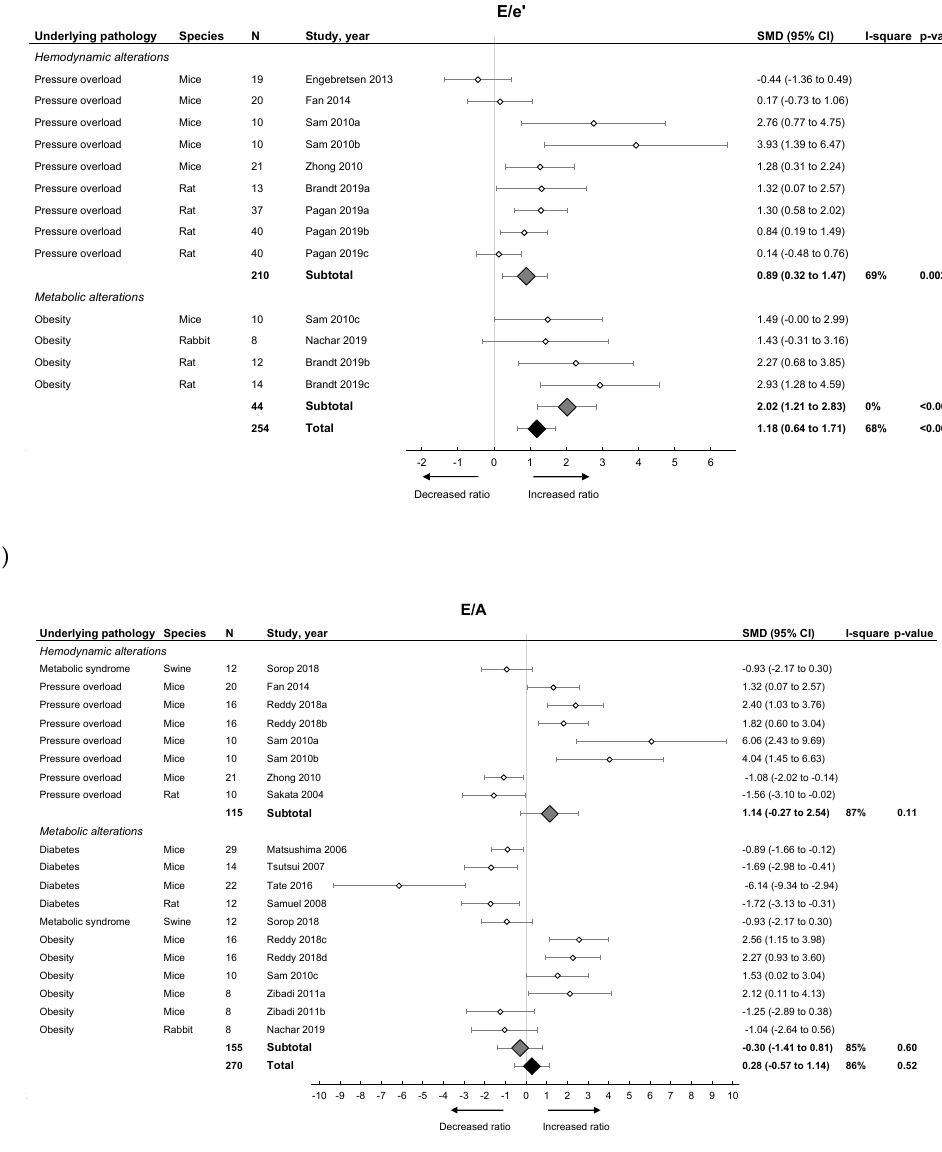
Figure 2. The effect of LVDD/HFpEF on cardiac parameters E/e’ (panel ( A )) and E/A (panel ( B )). Forrest plot; the right side shows an increased ratio in LVDD/HFpEF animals, the left side shows a decreased ratio in LVDD/HFpEF animals. Data are presented as standard mean differences (SMDs) with 95% CI. Arrows indicate increased and decreased E/e’ ratio ( A ), and increased and decreased E/A ratio ( B ) respectively. Only the first author of each study is shown; multiple comparisons within one study are shown with a, b, c or d and correspond with the study overview (Table S1). CI, confidence interval; E/A, ratio between peak early diastolic transmitral velocity (E) and late (atrial) transmitral flow velocity (A); E/e’, ratio between peak early diastolic transmitral velocity (E) and early diastolic mitral annular velocity (e’); I 2 , measurement of heterogeneity; N, cumulative sample size; SMD, standardized mean di ff